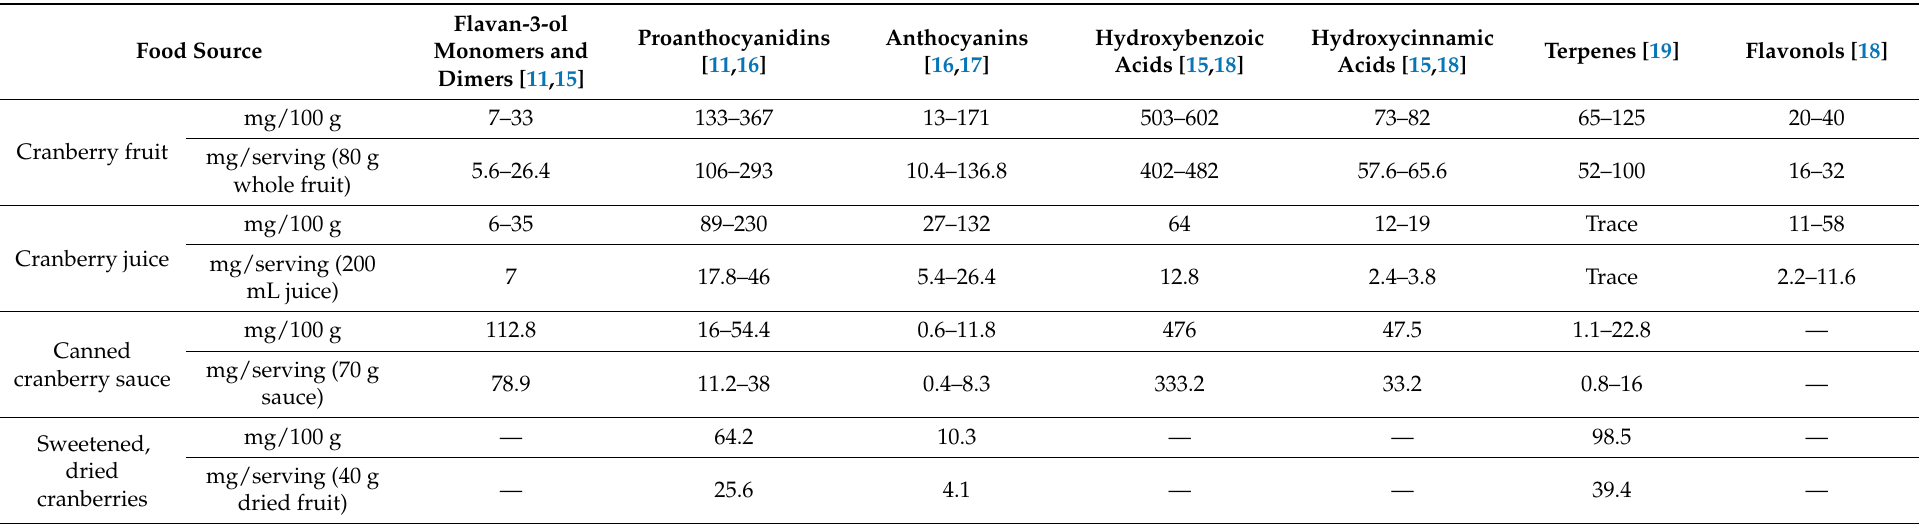
Table 1. Polyphenols content of cranberry foods (adapted from Blumberg et al. 2013